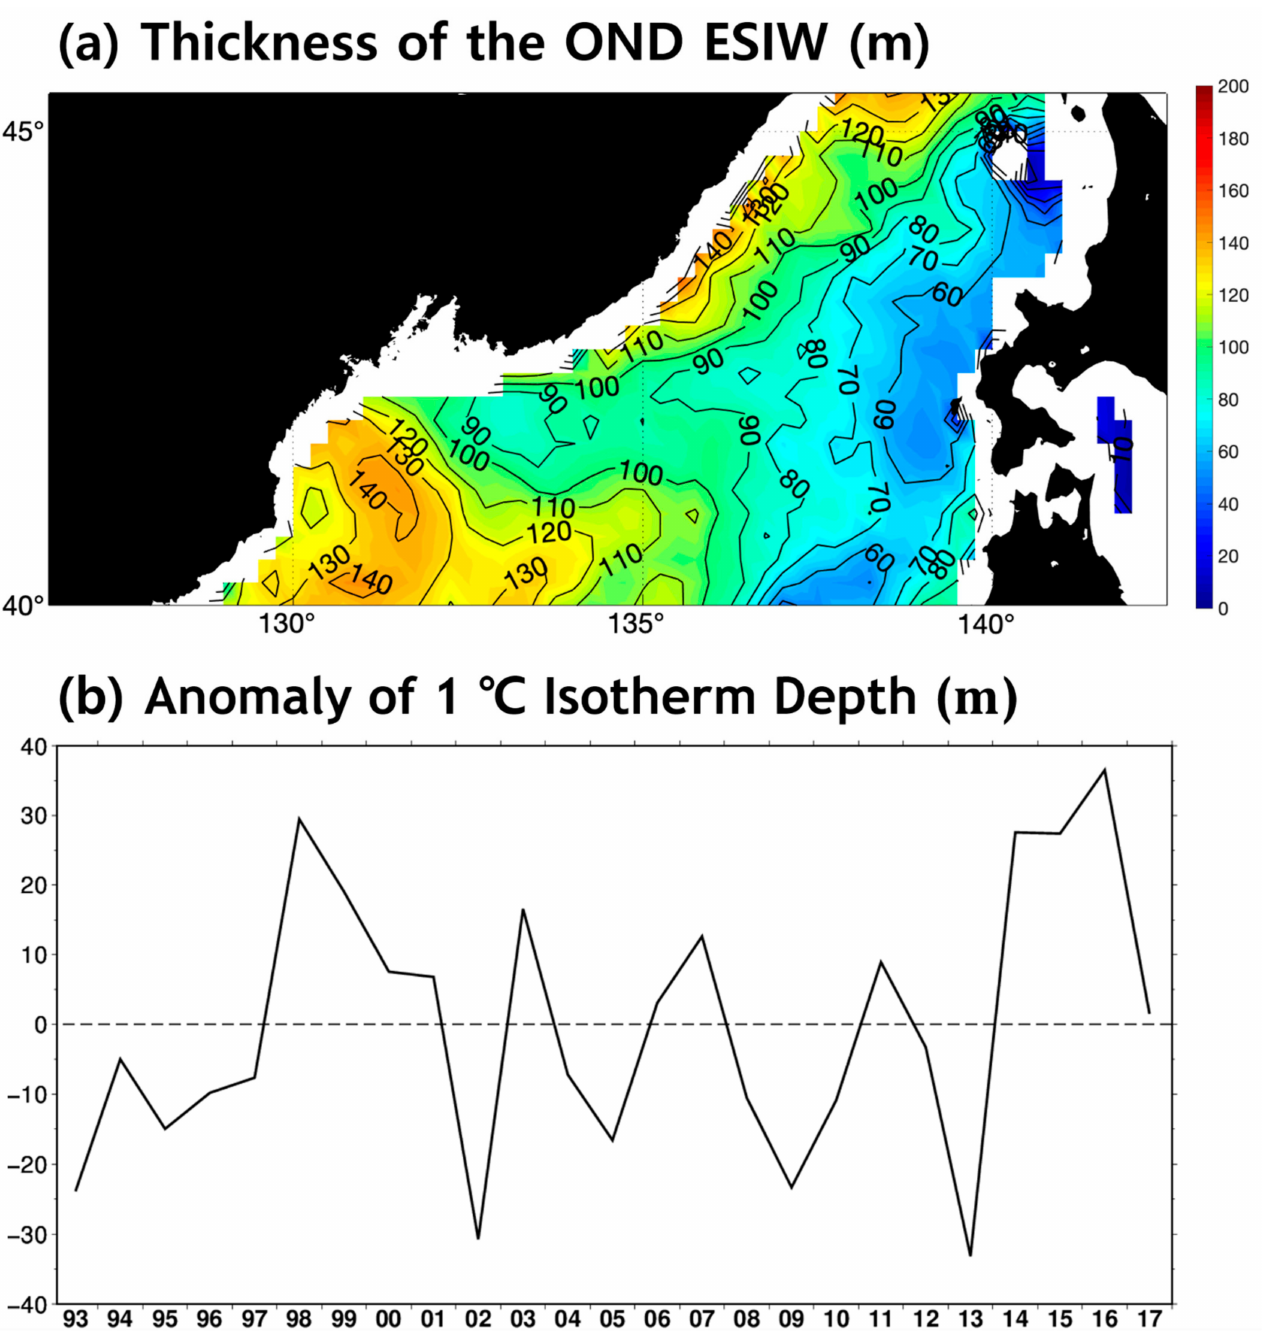
Figure 8. ( a ) Horizontal distribution of OND thickness of the East Sea Intermediate Water (ESIW) and ( b ) time series of OND 1 ◦ C isotherm depth anomaly in the region with positive SSH anomalies (red box in Figure 1). The ESIW thickness is estimated following the definition of the ESIW (0.6–5 ◦ C temperature, <34.06 psu salinity, and 26.9–27.3 kg/m 3 potential density, Park and Lim